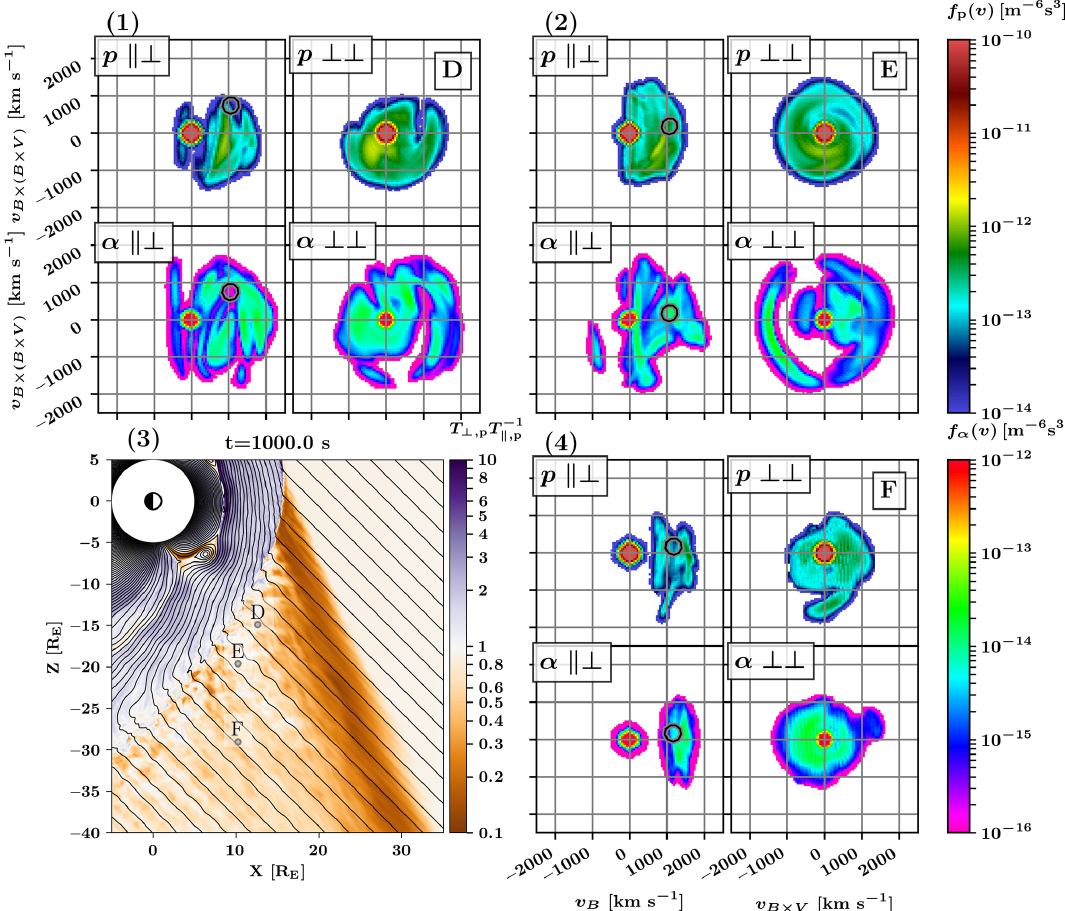
Figure 7. Velocity distribution functions for protons and alpha particles and their locations in the foreshock. (3) Map of the foreshock with three VDF positions indicated with capital letters. The colour indicates proton temperature anisotropy, with magnetic field lines in black. Panels (1) , (2) , and (4) show sets of four projections of ion VDFs at virtual spacecraft locations in the solar wind frame. Coordinates are chosen to represent two positions close to the quasi-parallel bow shock (D and E) and one deep within the outer foreshock (F). In each set, subpanels are labelled as v B versus v B × (B × V) ( (cid:107)⊥ ; left columns) or v B × V versus v B × (B × V) ( ⊥⊥ ; right columns) and protons (top rows) or helium (bottom rows). The black and white circles estimate the areas of specular